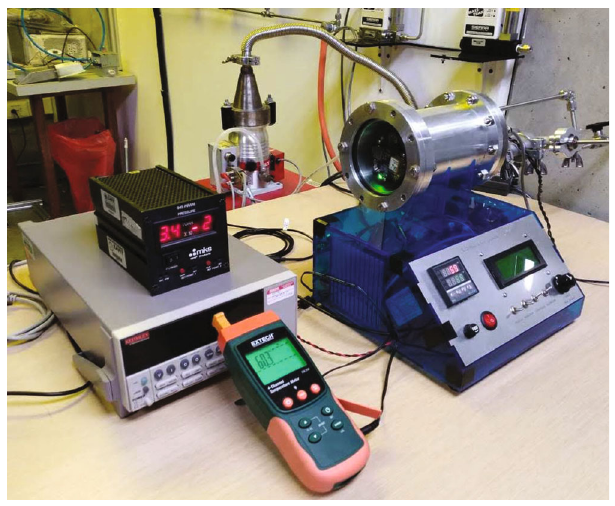
Figure 7: Thermal-vacuum chamber. Laboratory of Microengineering, Department of Physical Sciences at Universidad EAFIT. Table 2: Some CubeSat projects and their respective common temperature ranges (maximum and minimum levels), vacuum level, and number of cycles [30]. CubeSat Model